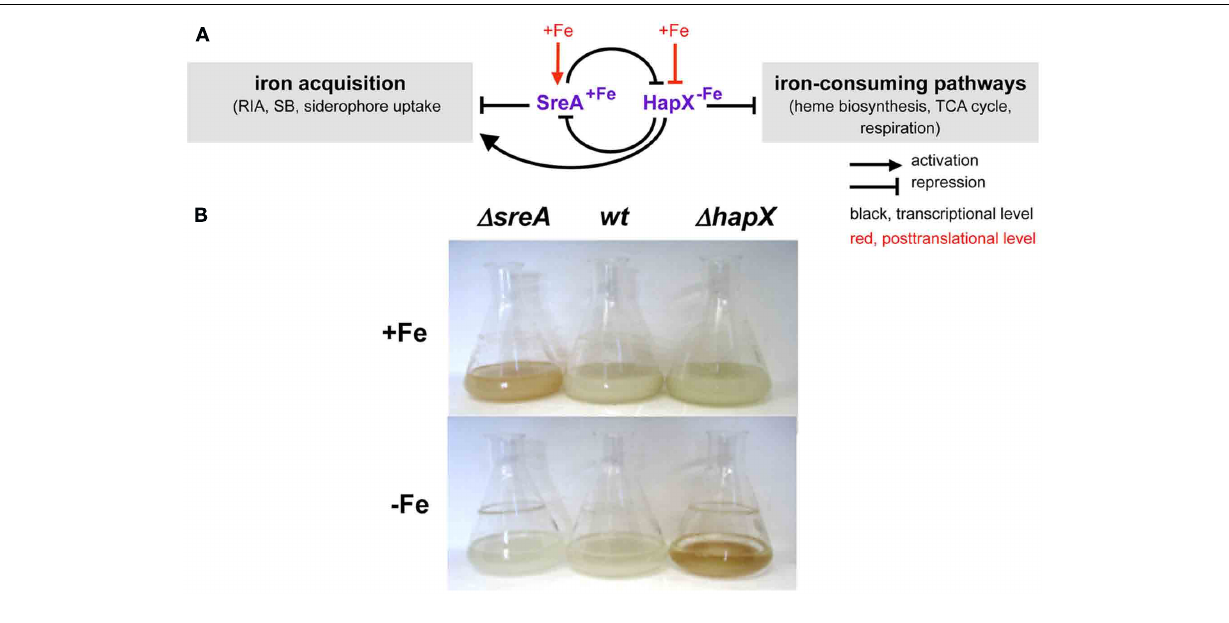
FIGURE 3 | Iron regulation in Aspergillus spp. (A) Scheme of SreA- and HapX-mediated iron regulation. (B) Phenotypes of A. fumigatus SreA-( Δ sreA ) and HapX-( Δ hapX ) deficient mutant strains in 24h/37˚C flask cultures. In contrast to the wild type ( wt ), Δ hapX mycelia are